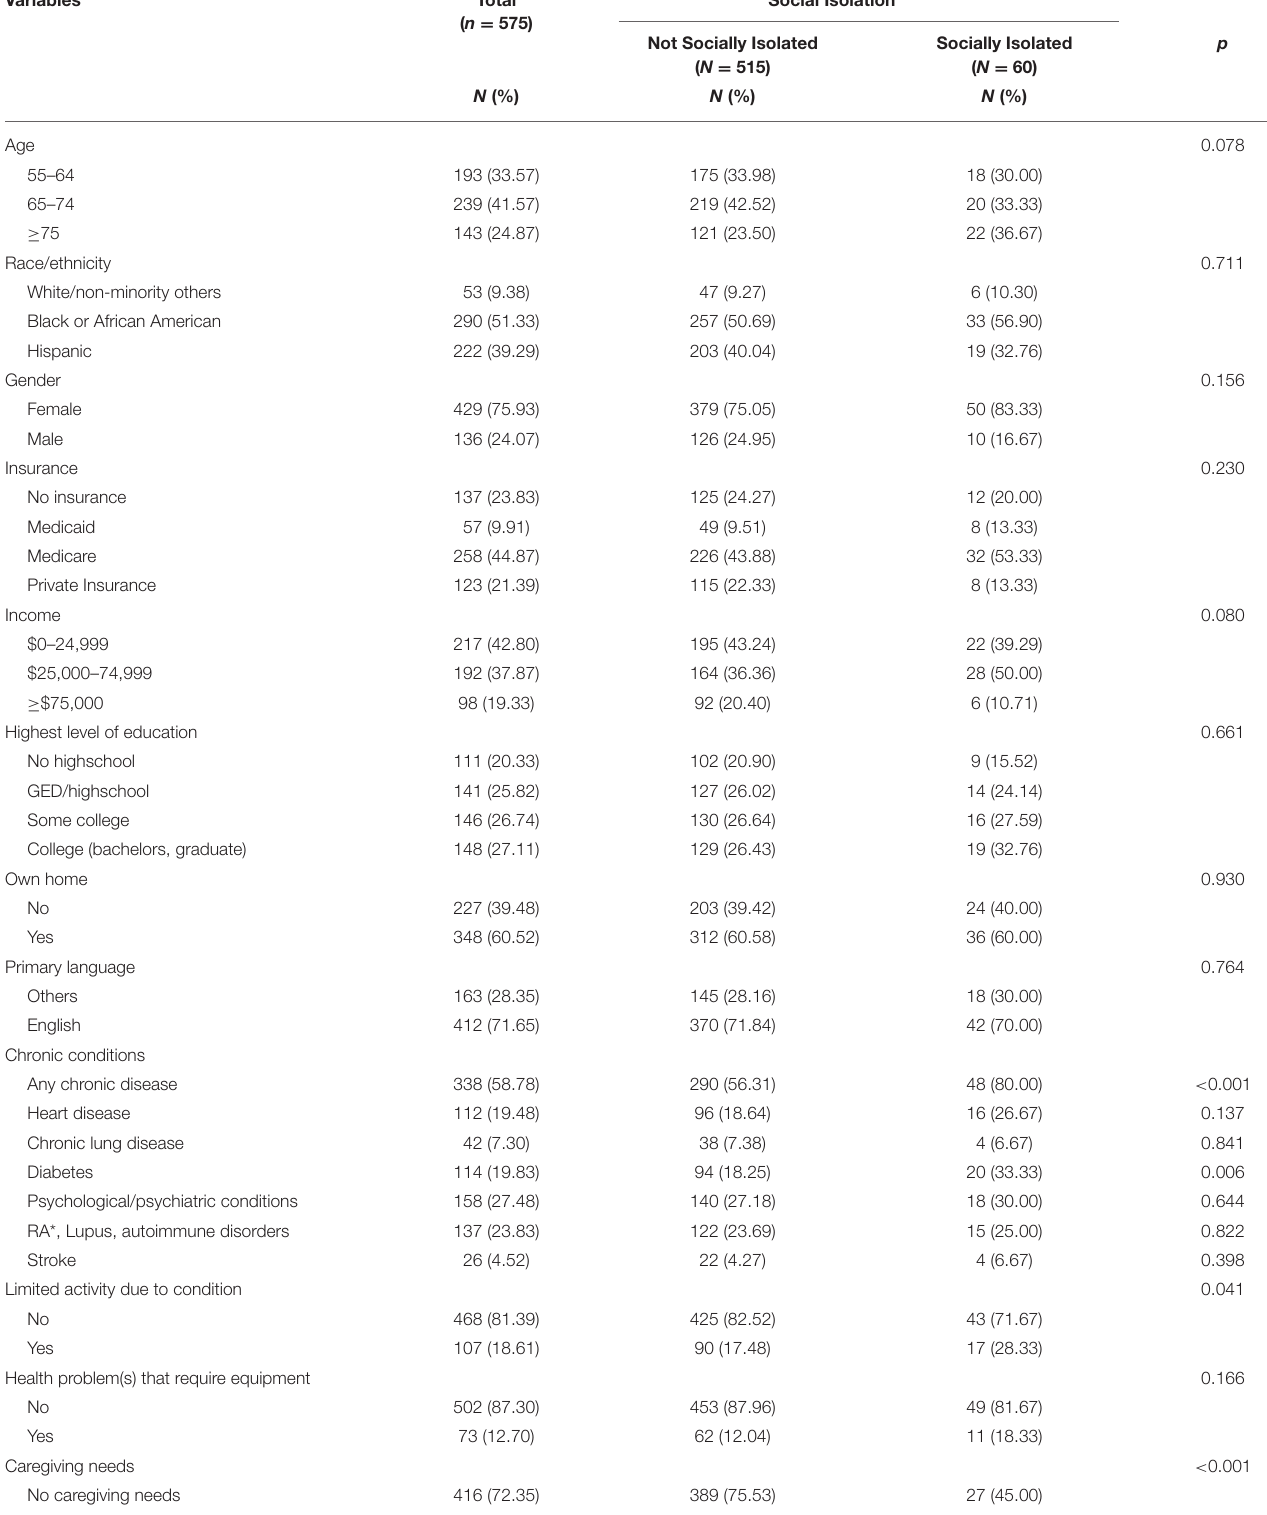
TABLE 1 | Bivariate associations of survey respondents by social